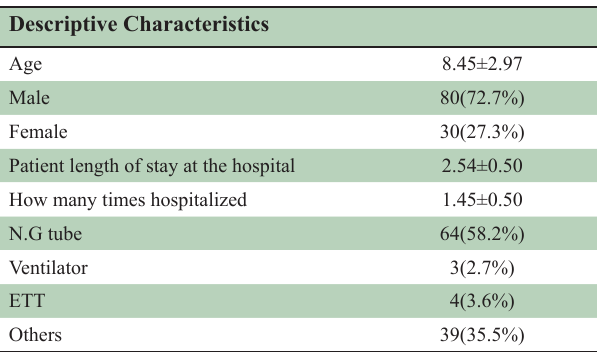
Table–I: Demographic characteristics of participants.